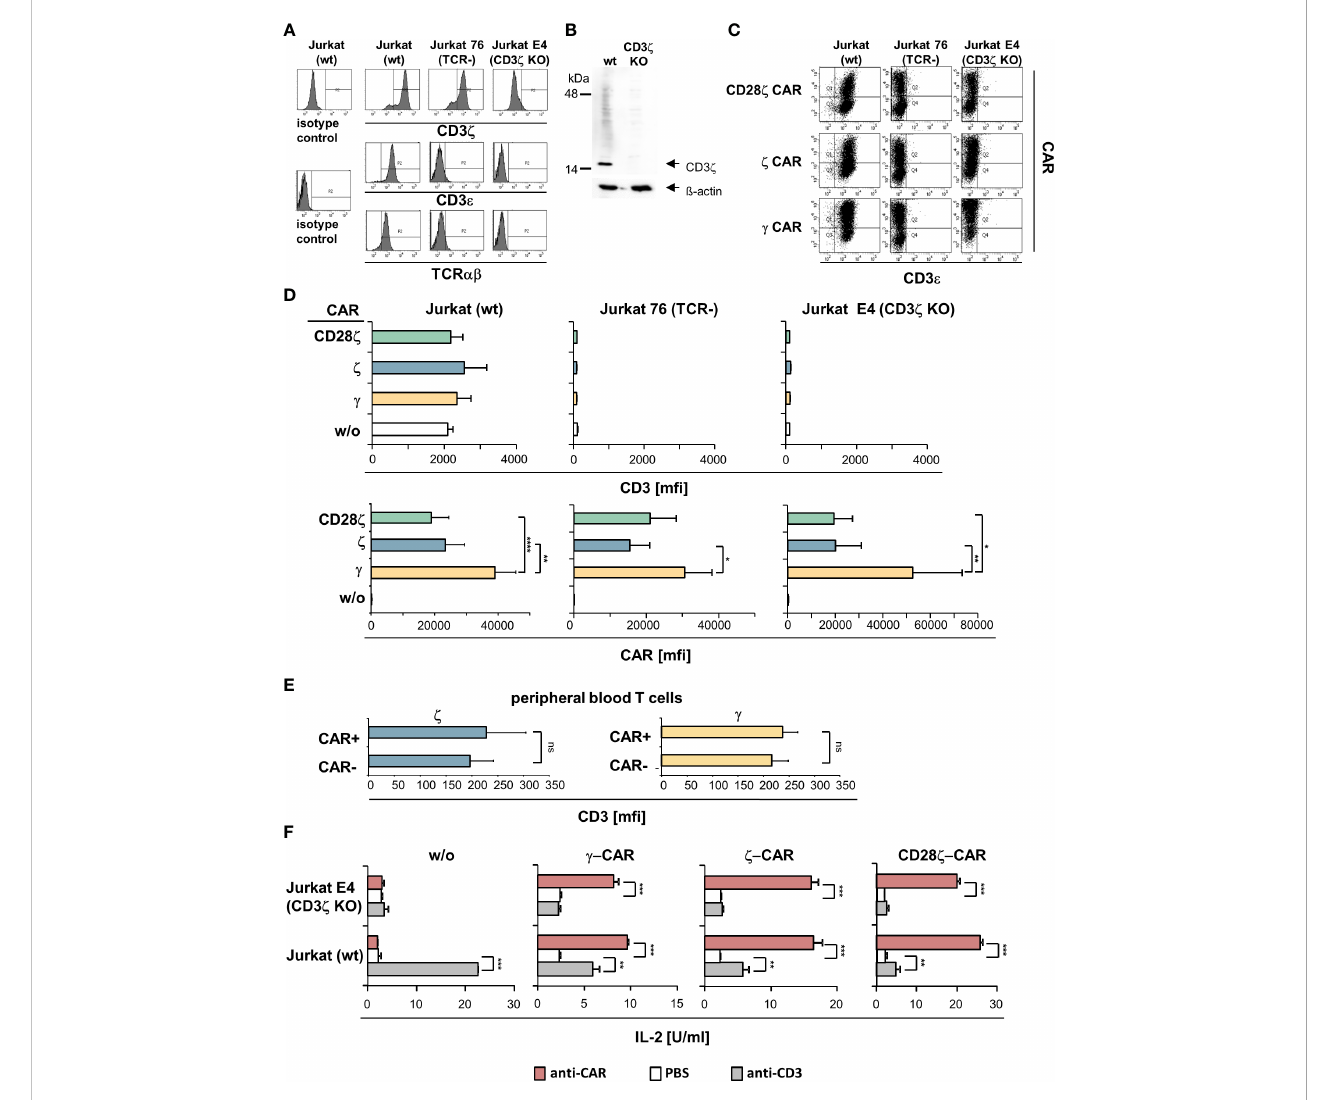
FIGURE 2 z CARs did not rescue the CD3/TCR complex in CD3 z KO Jurkat cells. (A) The CD3 z locus in Jurkat cells was deleted by CRISPR/Cas9 engineering as described in Materials and Methods. Non-modi fi ed Jurkat cells (wt), Jurkat76 cells lacking TCR (TCR - ) and Jurkat E4 CD3 z knock-out (KO) cells were tested by fl ow cytometry for intracellular CD3 z expression and for surface expression of CD3 e and TCR, respectively. Histograms of a representative analysis are shown. (B) Western blots of genome edited Jurkat cells. Lysates of non-modi fi ed (wt) and CD3 z KO Jurkat cells (5 µg protein lysate/lane) were separated by SDS PAGE, blotted, probed with a mouse anti − human CD3 z antibody (1:500) and detected by a HRP-conjugated anti − mouse antibody (1:5,000). Blots were re-probed with an anti − b -actin antibody (1:20,000). (C) TCR + Jurkat (wt), Jurkat76 (TCR - ) and Jurkat E4 (CD3 z KO) cells were engineered with the CD28 z , z or g CAR, respectively. Expression of CARs and surface expression of CD3 was recorded by fl ow cytometry and mean fl uorescence intensity (m fi ) was determined. Dot plots of a typical experiment and mean values of 5 independent experiments ± SD (D) are shown. Signi fi cant differences were determined by Student´s T test. (E) Peripheral blood T cells engineered with z − chain and g − chain CAR, respectively, were stained for CAR and CD3 expression and analyzed by fl ow cytometry. CAR + and CAR - T cells were gated and mean fl uorescence intensity (m fi ) of CD3 was determined. Data represent mean values of 4 healthy donors ± SD. Statistical differences were determined by Student´s T test. (F) Jurkat (wt) and Jurkat E4 (CD3 z KO) cells with and without CAR, respectively, were stimulated through the CAR and CD3 by incubation on 96-well plates (4 x 10 4 cells/ well) coated with the agonistic anti − CD3 antibody OKT3 or anti − IgG Fc antibody (5 µg/ml each) that binds to the CAR extracellular domain. After 48 h supernatants were tested for IL − 2 by ELISA. Values represent the means of technical triplicates ± SD. Signi fi cant differences were determined by Student´ s T test. A representative experiment out of two is shown. p-values <0.05 were considered statistically signi fi cant (*p<0.05; **p<0.01; ***p<0.001; ****p<0.001; ns, not signi fi